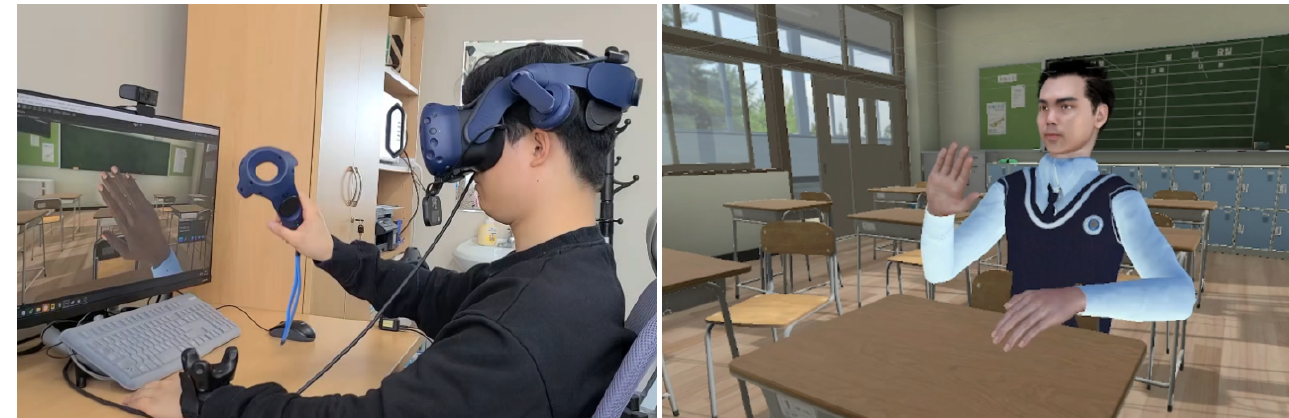
Figure 5. Result of motion